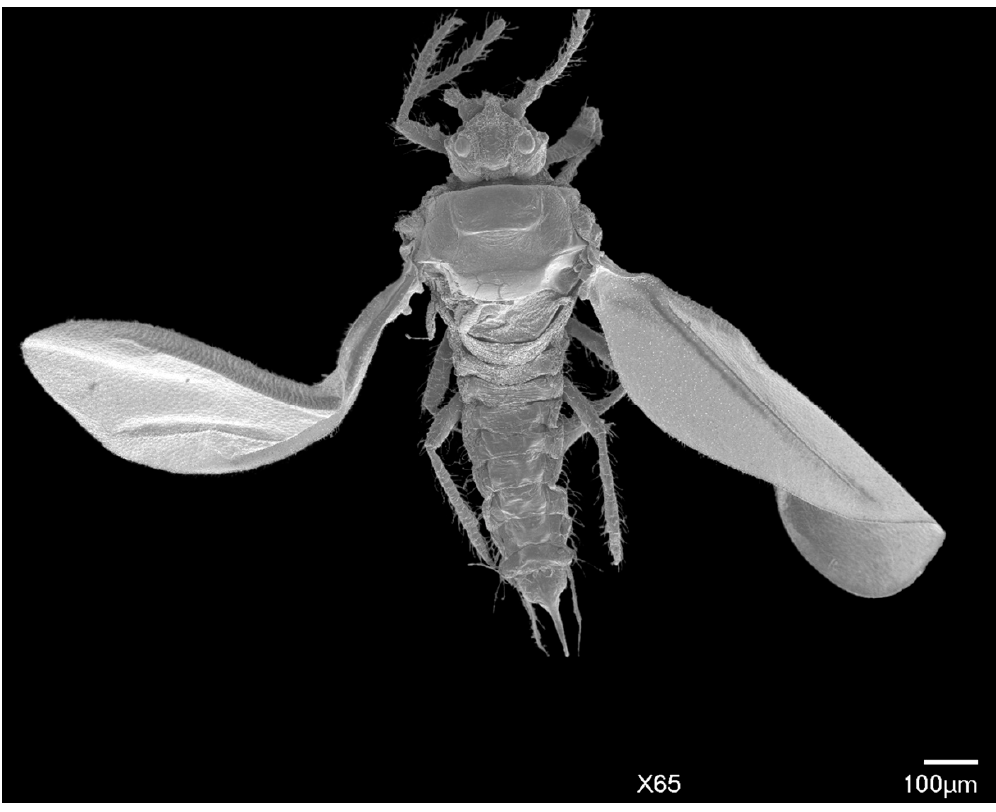
Figure 2. SEM dorsal view of the entire male Allokermes galliformis.